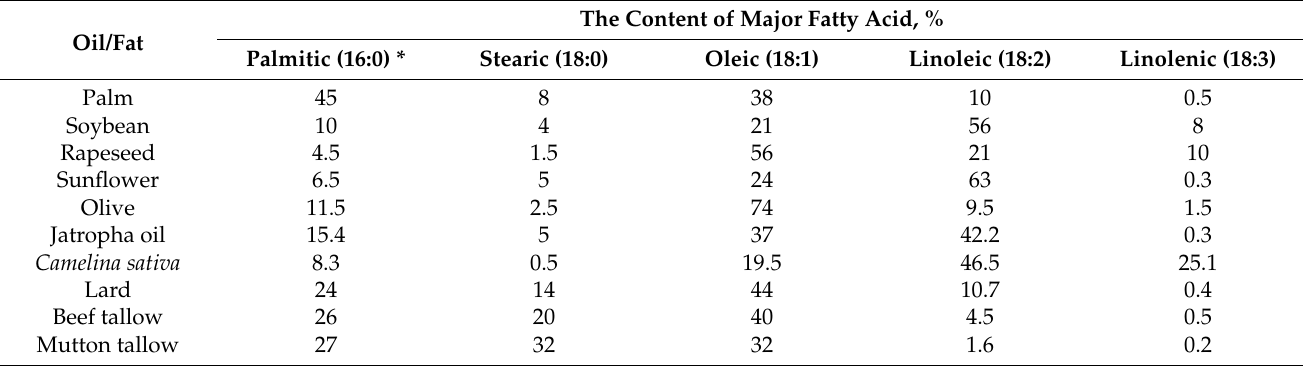
Table 1. The content of fatty acids in various types of vegetable oils and animal fats [22,24].